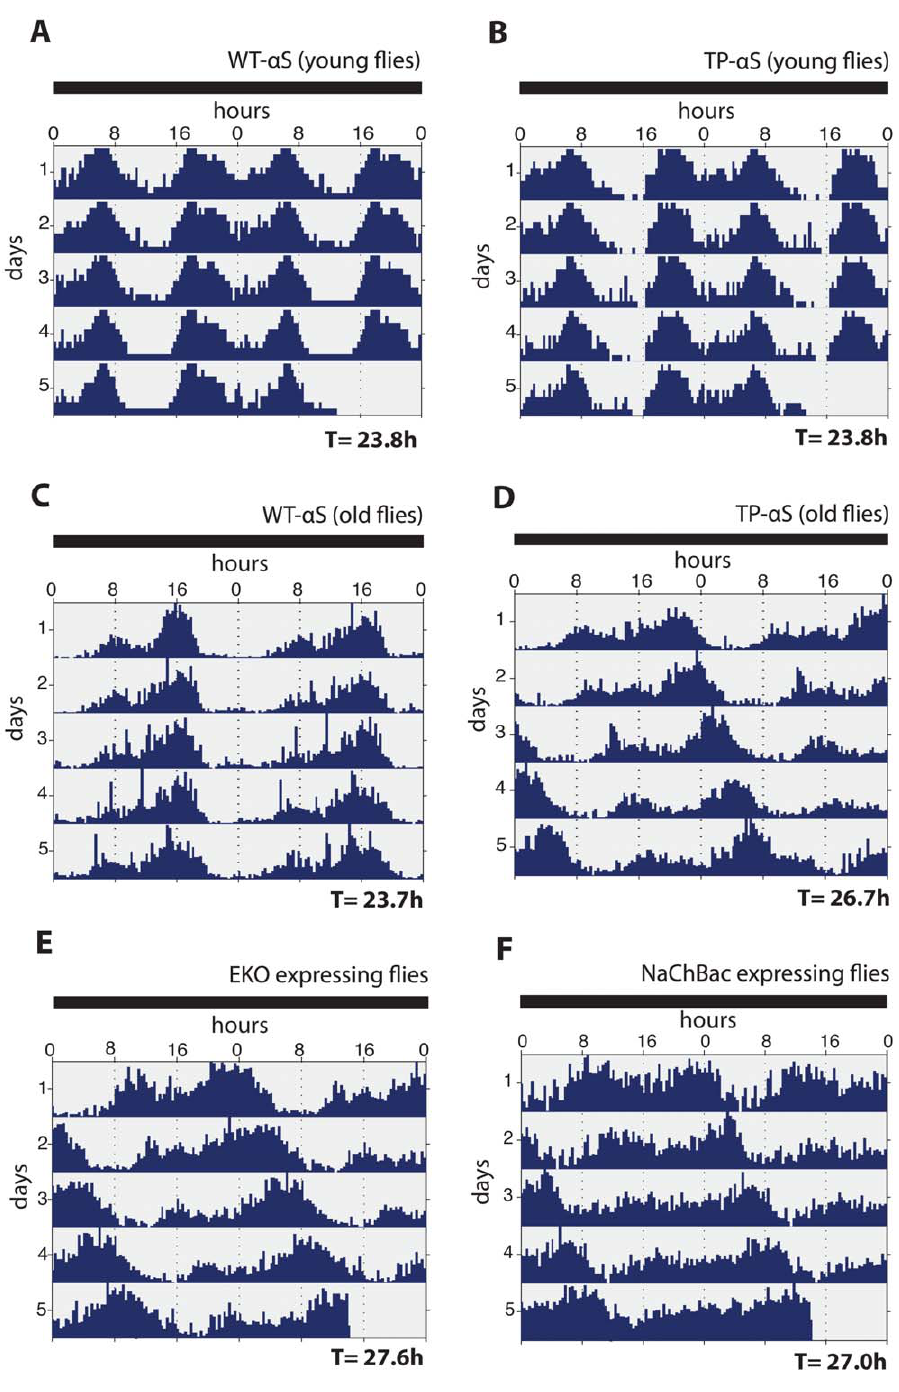
Figure 3. Age-dependent circadian defects in response to wild type a S, TP- a S, EKO/Kir2.1 and NaChBac expression in DA neurons. ( A , B ) Double-plotted actograms of young flies (3 days after hatching) expressing wild type a S (WT- a S) (A) and TP- a S (B) under the control of the DA neuron specific TH-Gal4 driver. T refers to circadian periodicity which is 23.8 hrs in both cases. ( C , D ) Double-plotted actograms of old flies (30 days after hatching) expressing WT- a S and TP- a S. Note the different circadian periodicity in response to WT- a S (T=23.7 hrs) and TP- a S expression (T=26.7 hrs). ( E , F ) Double-plotted actogram of old flies expressing EKO/Kir2.1 (E) or NaChBac (F) under the control of the DA neuron specific TH-Gal4 driver. Note the similar extension of the circadian periodicities (T=27.6 hrs and T=27.0 hrs, respectively) as observed after TP- a S expression. All experiments (n=32–58 flies) were carried out under constant dark conditions after the animals were kept in a dark-light cycle of 12:12 hrs. T was calculated by the Chi-squared periodogram analysis (see Materials and Methods).